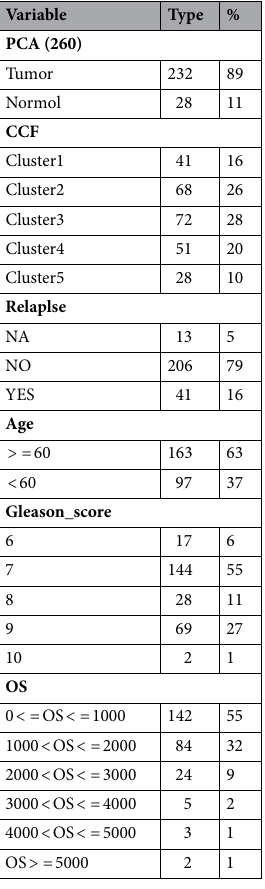
Table 1. Information on the clinical features of patients with prostate